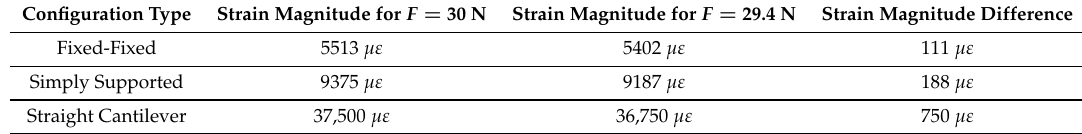
Table 1. Strain sensitivity in different beam configurations